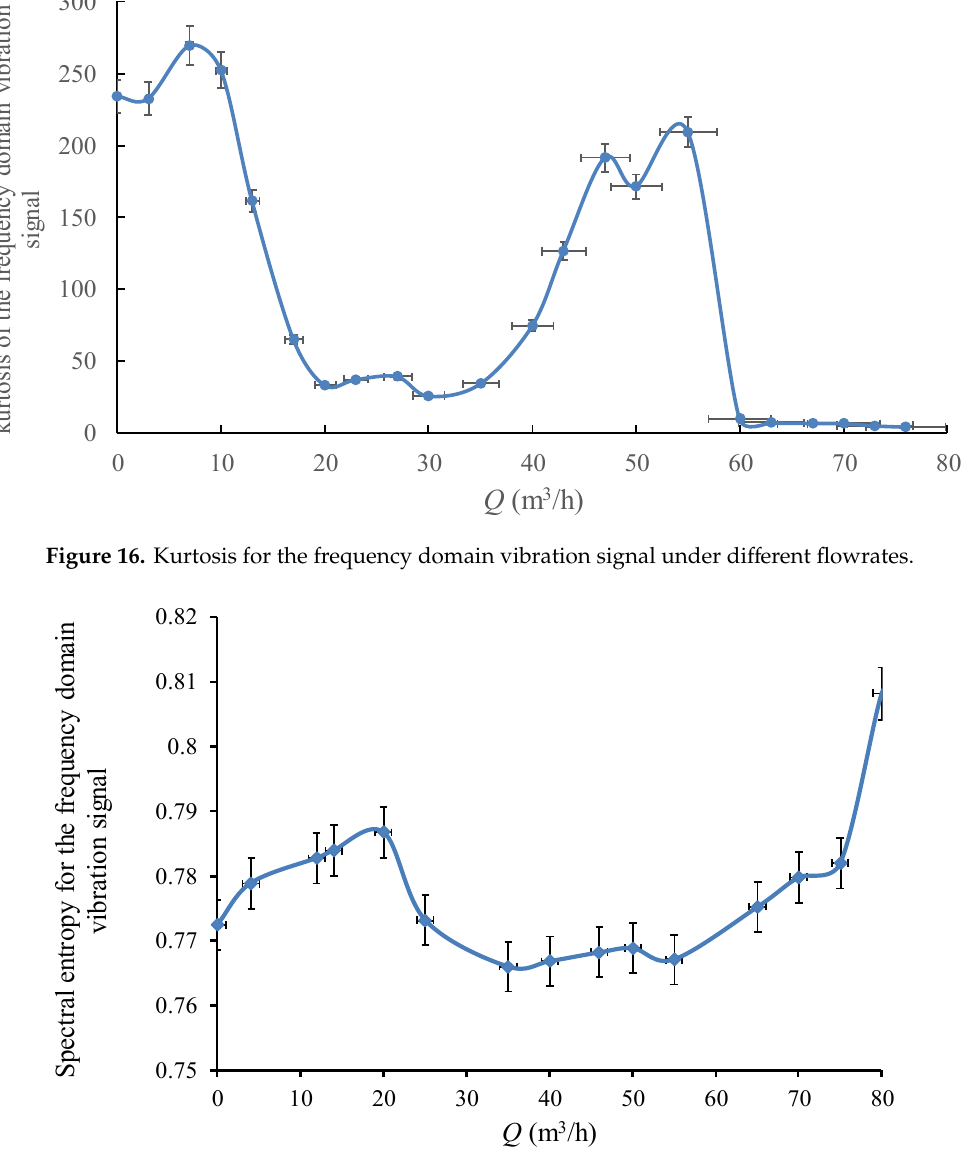
Figure 17. Spectral entropy for the frequency domain vibration signal under different flowrates.